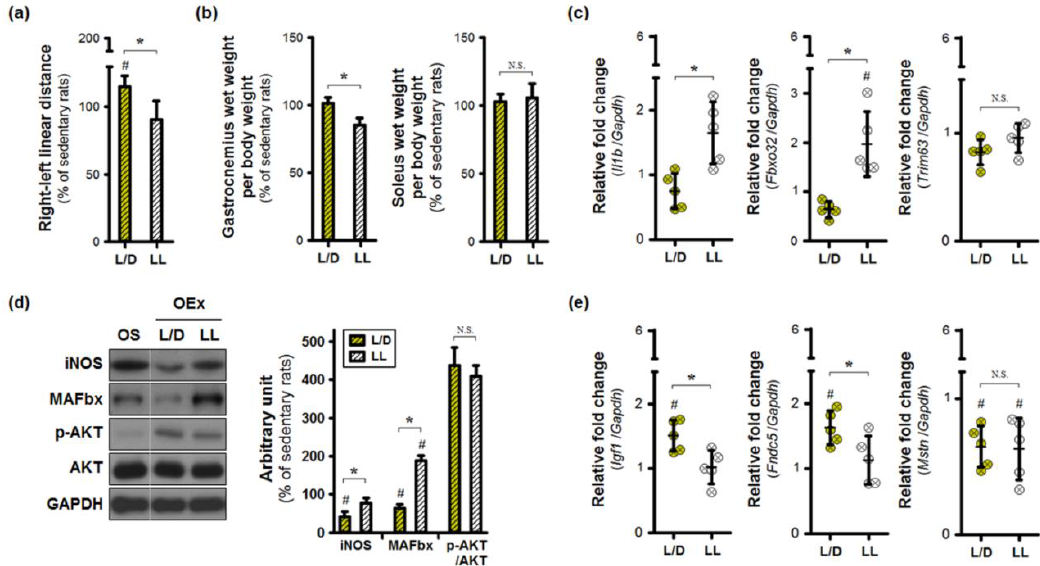
Figure 4. Exercise training under aberrant lighting conditions contributes to muscular inflammation. ( a ) Right-to-left linear distances during locomotion (n = 32 for each condition) were normalized, relative to those of sedentary rats. ( b ) Wet muscle weight was measured, not only in the gastrocnemius, but also in the soleus. ( c ) Expression of inflammatory (Il1b) and catabolic markers (Fbxo32, Trim63) was measured by real-time qPCR in the gastrocnemius muscle. ( d ) The proteins involved in skeletal muscle metabolism were analyzed by immunoblotting in the gastrocnemius. ( e ) Expression of Igf1 , Fndc5 , and Mstn mRNA were analyzed by real-time qPCR and compared against values from the sedentary group. * p < 0.05 L / D vs. LL; # p < 0.05 Sedentary vs. Exercise-trained; N.S. not significant.